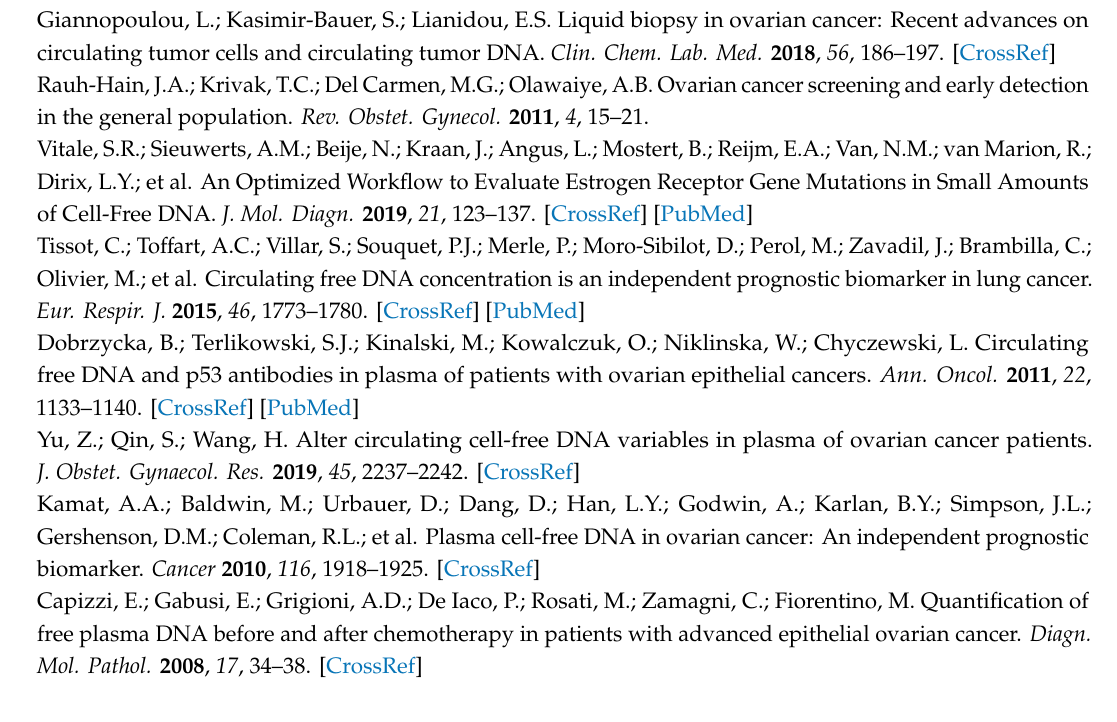
Table S1: Digital PCR SNP genotyping assays used for subset I, Table S2: Digital PCR primers and probe sequences, Figure S1: TP53 mutation analysis by digital PCR in patient